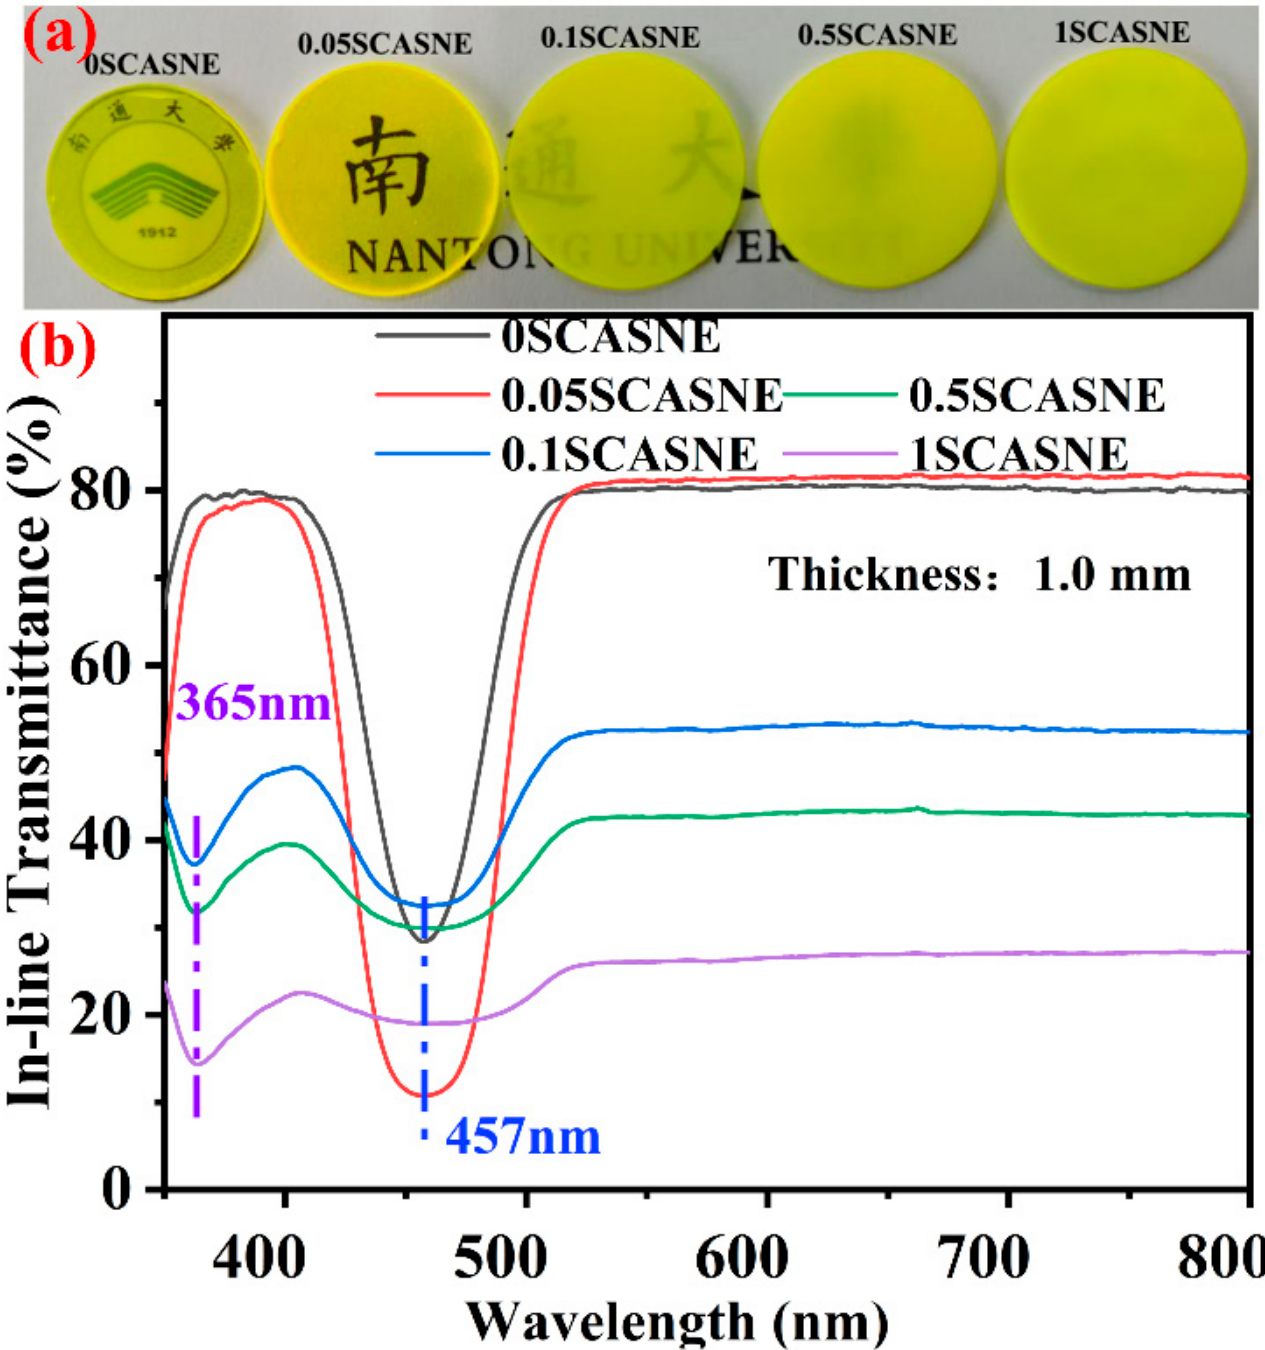
Figure 6. ( a ) Photograph of serial SCASNE ceramics with 1 mm thickness under daylight and ( b ) the optical-transmittance spectra under 350–800 nm wavelengths.